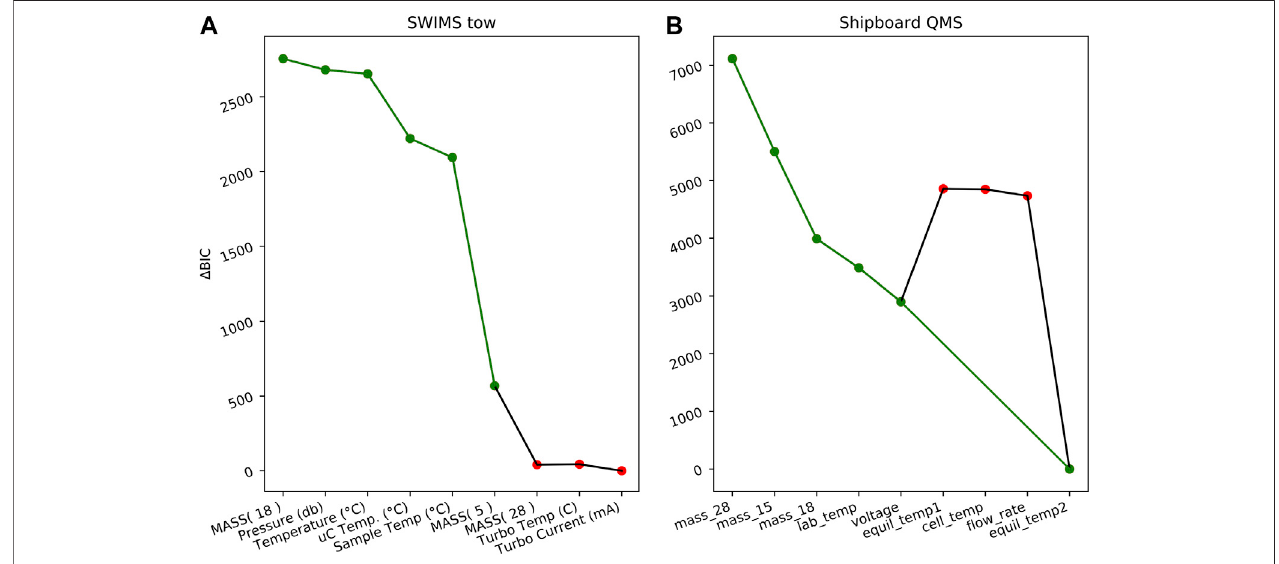
FIGURE6| ThenormalizedBayesianinformationcriterion( Δ BIC )whichwasusedtodeterminethesetoftheenvironmental correlatesthatbestreproducethebias in the GAM model. The black line with red dots indicates environmental correlates that did not measurably improve the Δ BIC score. These were left out of the fi nal set of environmental correlates, which are indicated by the green line and green